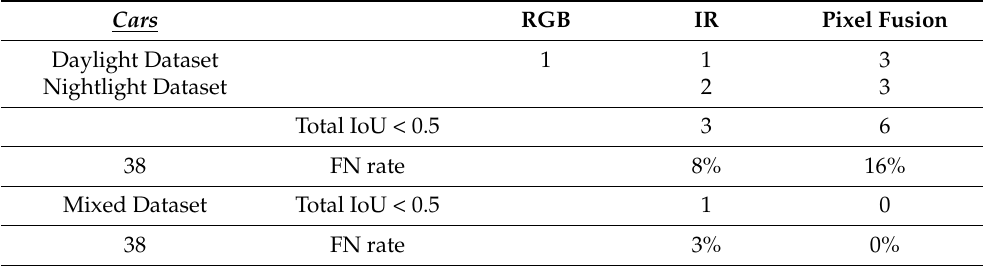
Table 7. Number of images out of Test DS images in which the trained networks failed to classify car objects, with IoU detection rate lower than 0.5. Columns: DSs used to train the network (i.e., RGB images (daylight dataset only), IR images, and pixel-level fused images). Rows: the actual part of the dataset the network was trained with (i.e., Daylight dataset, Nightlight dataset and Mixed dataset). Cars RGB IR Pixel Fusion Daylight Dataset 1 1 3 Nightlight Dataset 2 Total IoU < 0.5